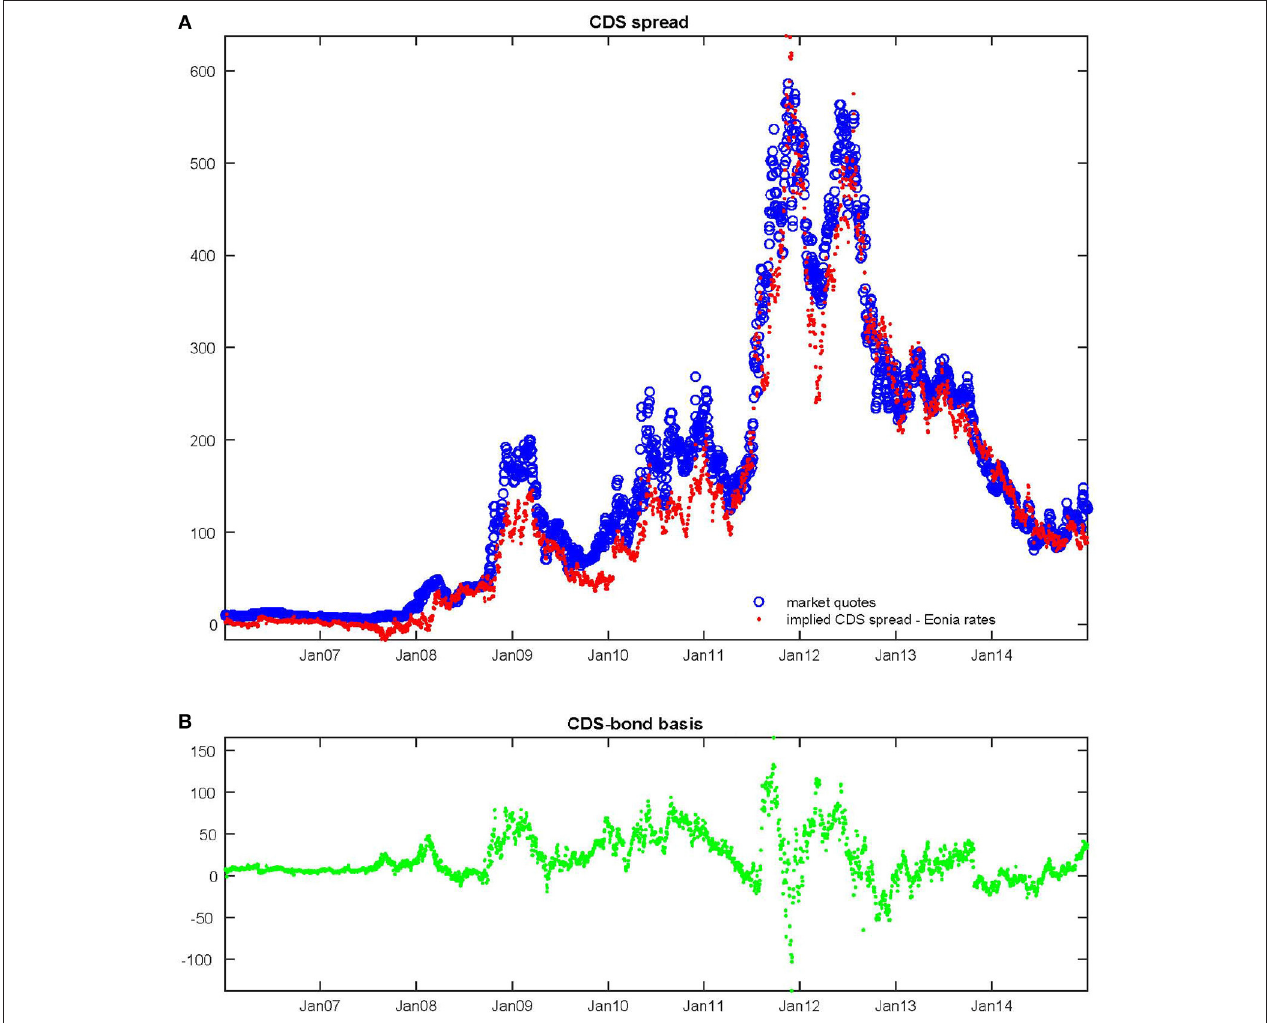
FIGURE 2 | Observed 5-year CDS spread, implied 5-year CDS spread and 5-year CDS-bond basis from January 02, 2006 to December 31, 2014. We report (A) the observed Italian 5-year CDS spread, the implied 5-year CDS spread computed as difference between the observed Italian 5-year bond yield and the 5-year Eonia swap rate; (B) the 5-year CDS-bond basis, that is the difference between the observed CDS spread and the implied